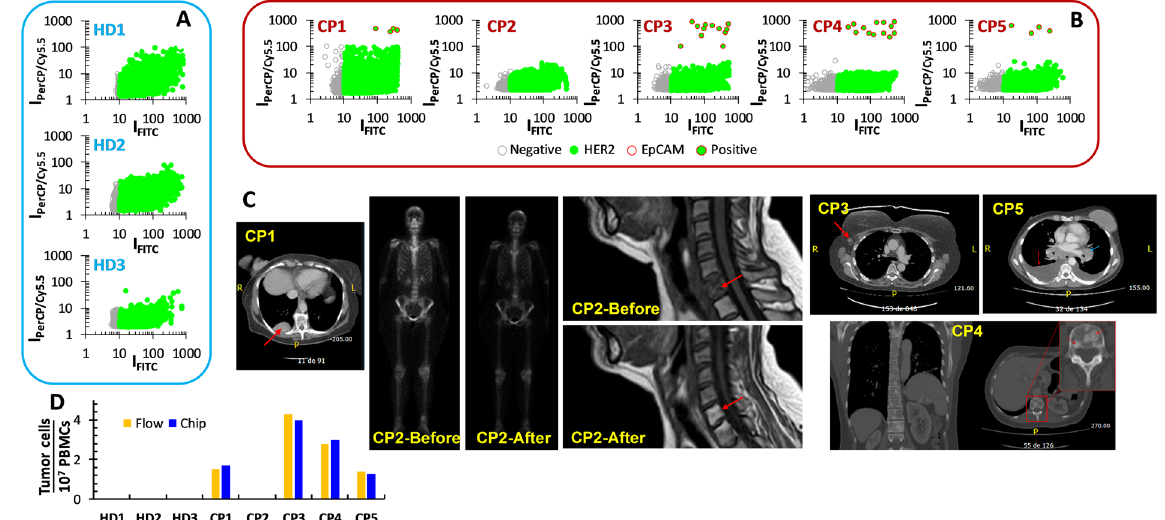
Figure 3. Optofluidic results for blood samples, and computerised tomography of cancer patients at the time of blood extraction. ( A ) 3 healthy donors and ( B ) 5 cancer patients. ( C ) Computerised tomography scans of the cancer patients at the time of blood extraction. CP1, lung metastasis (red arrow). CP2, bone scintigraphy and MRI before (showing a lytic metastasis in C6) and at the time of blood extraction (complete remission). CP3, recently diagnosed and untreated yet metastatic adenopathy (red arrow). CP4, vertebral osteoblastic metastasis showing the current bone progression of the disease (red arrow). CP5, malignant pleural effusion (red